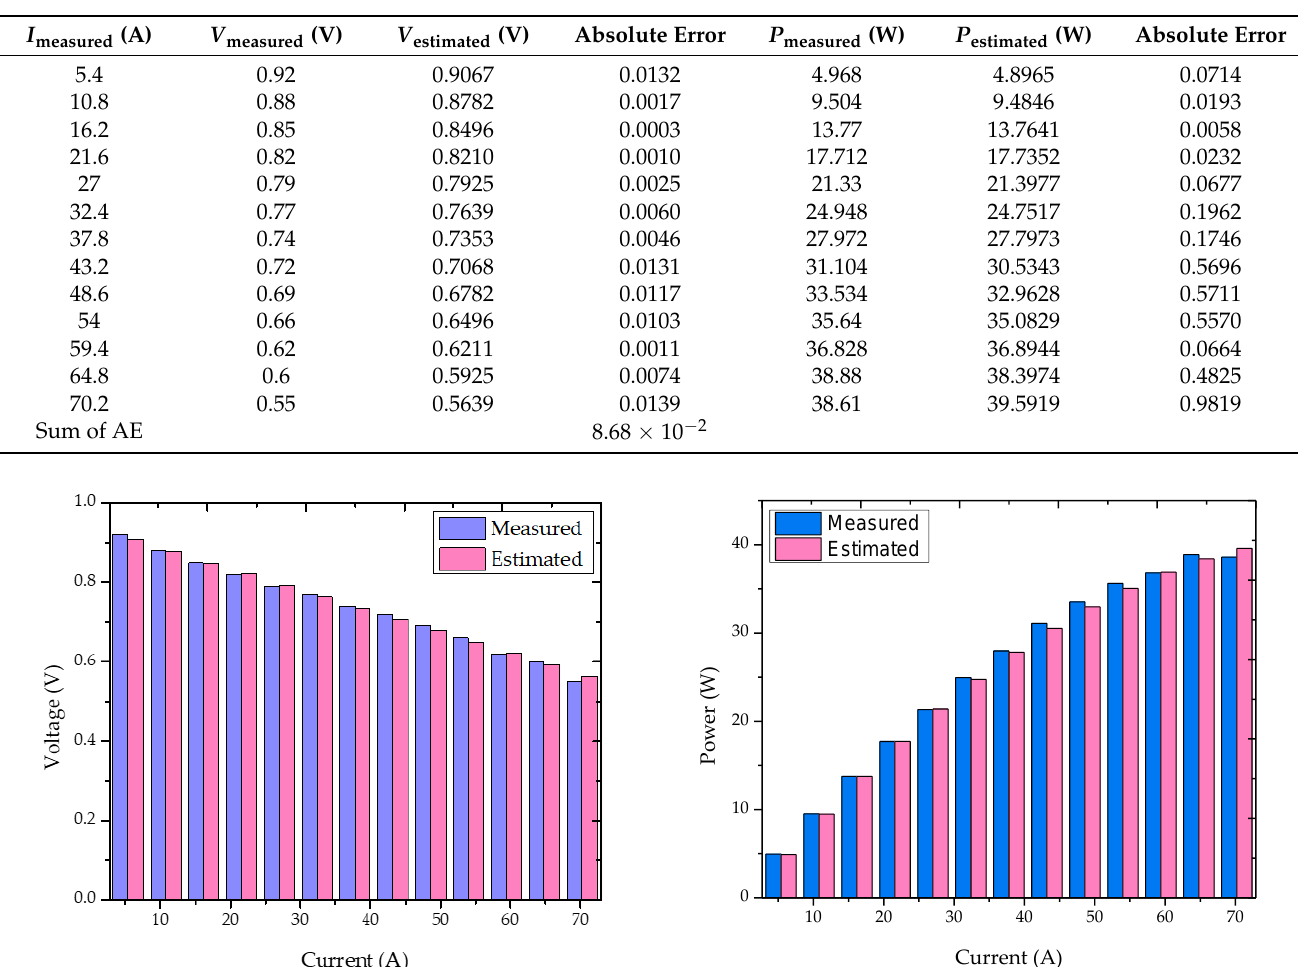
Table 6. Estimated values of voltage and power for Ballard Mark V PEMFC.